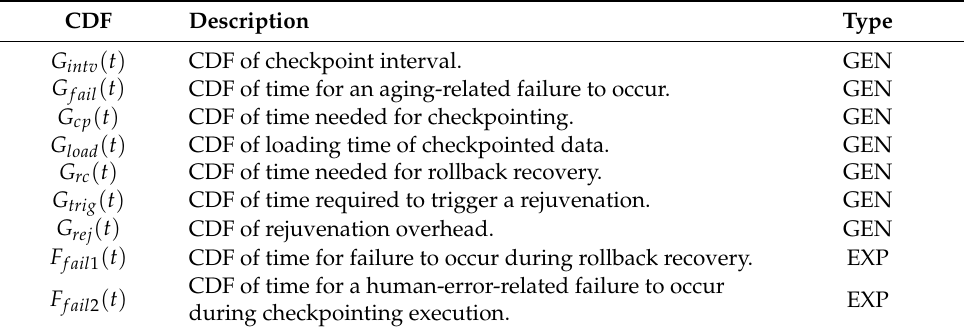
Table 4. Cumulative distribution functions (CDFs) of transitions in state-transition